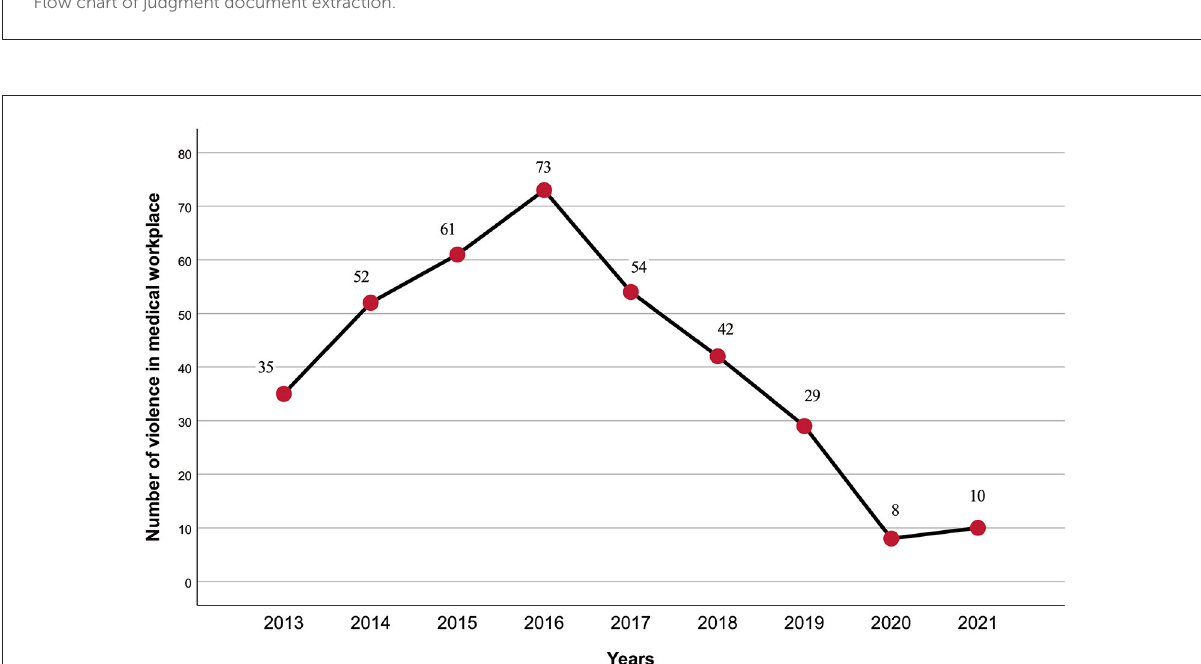
FIGURE2 The frequency of medical workplace violence between 2013 and 2021.